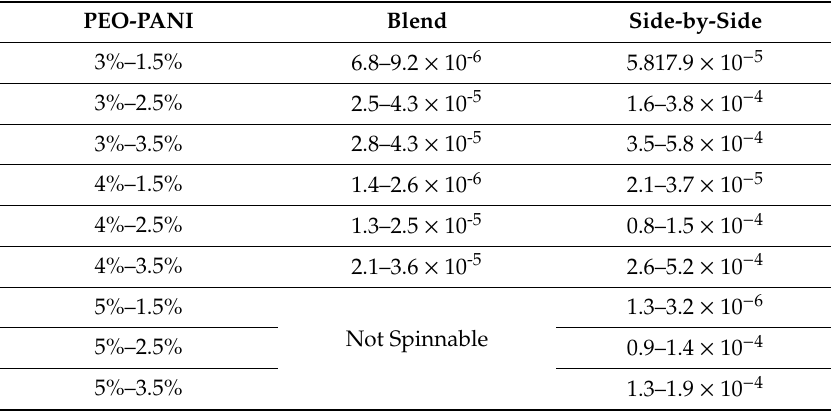
Table 2. Electrical conductivity (S / cm) for side-by-side and